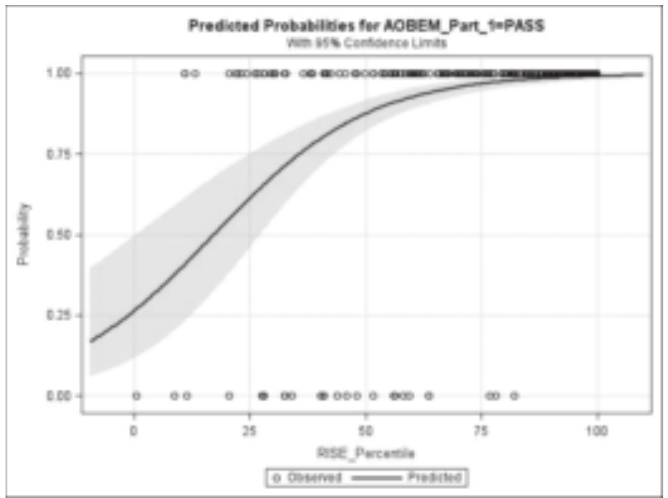
Figure 4: A logistic regression analysis curve predicting the probability of passing the American Osteopathic Board of Emergency Medicine (AOBEM) Part 1 based on Resident In- Service Examination percentile according to the analyzed data.